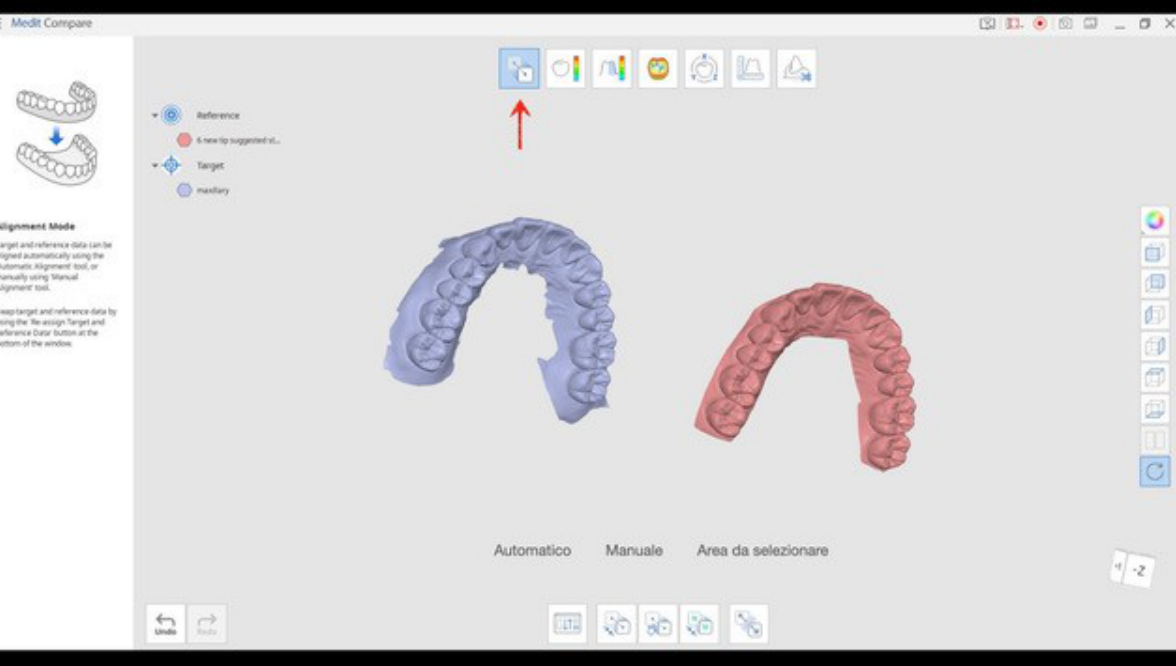
Figure 4. The STL file of the RG and that of the TG were uploaded into the software. The arrow indicates the tool to be used for the alignment of the two STL files.